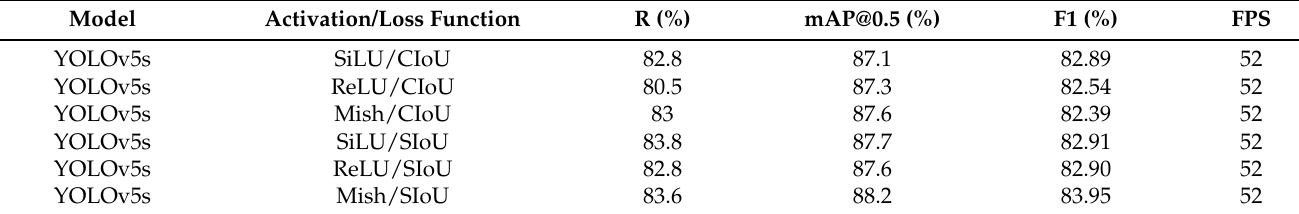
Table 6. Effects of different activation functions and loss functions on the same model.